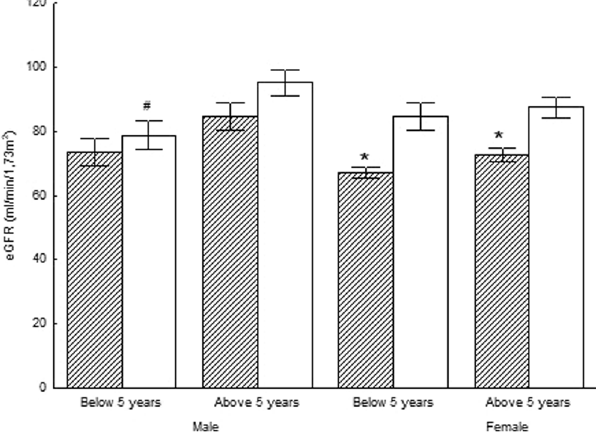
Figure 1. Estimated Glomelural Filtration Rate (eGFR) in the IUGR (hatched bars) and AGA (white bars) groups. Significant differences were assessed by One-Way factors ANOVA (p < 0.05). + denotes statistically significant difference from the respective female group. * denotes statistically significant difference from the respective AGA group. # denotes statistically significant difference from the respective group of more than 5 years old